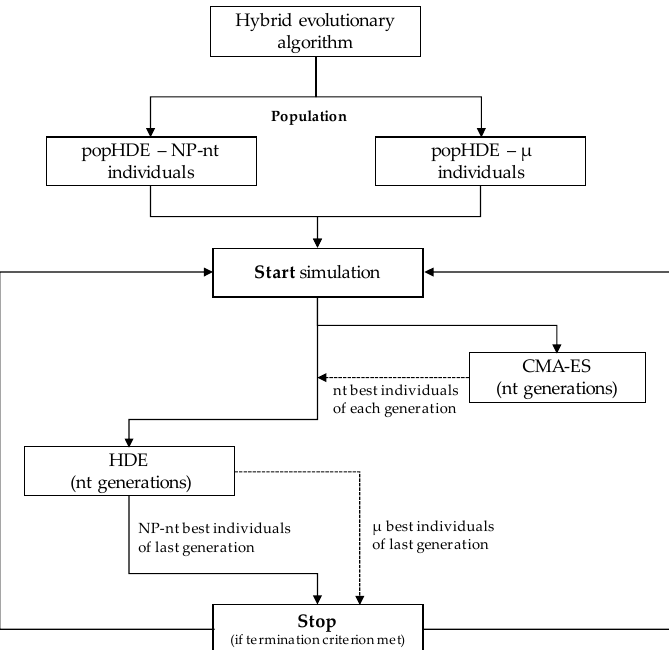
Figure 1. Scheme of covariance matrix adaptation evolution strategies (CMA-ES) and hybrid differential evolution (HDE) algorithms (adapted from Reference [19]).